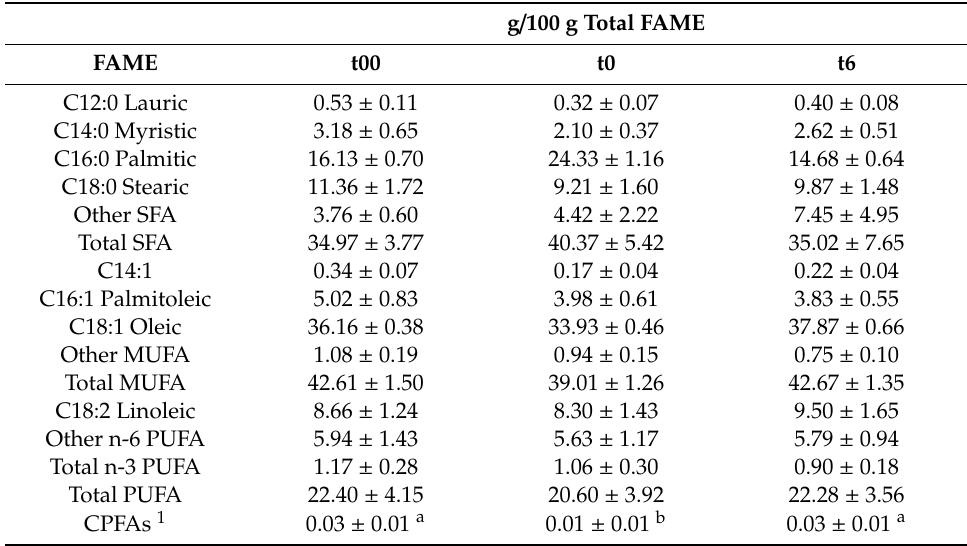
Table 4. General fatty acids composition (g / 100 g) of total fatty acids methyl esters (FAME) detected in human plasma at the selected timepoints (t00, t0,